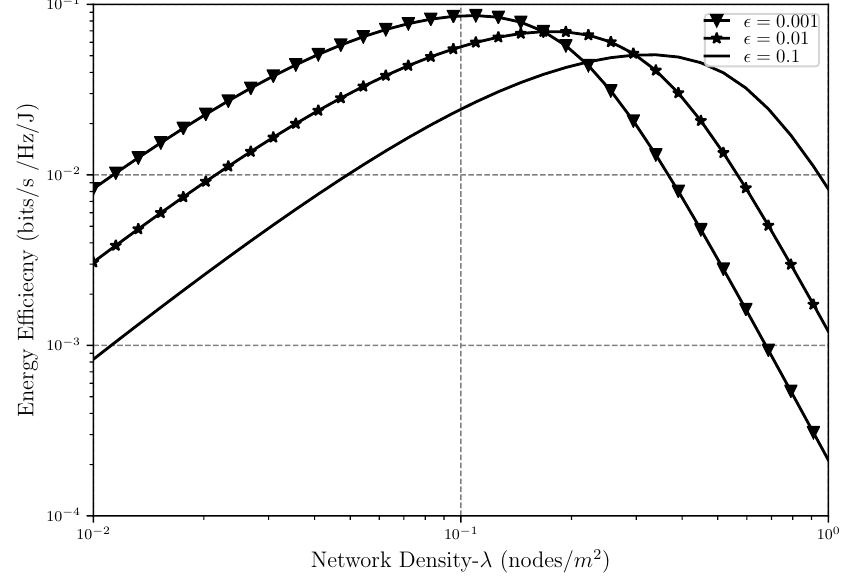
Figure 8. Energy efficiency EE versus the network density λ with different outage threshold (cid:101) levels and α = 4, r 0 = 1.